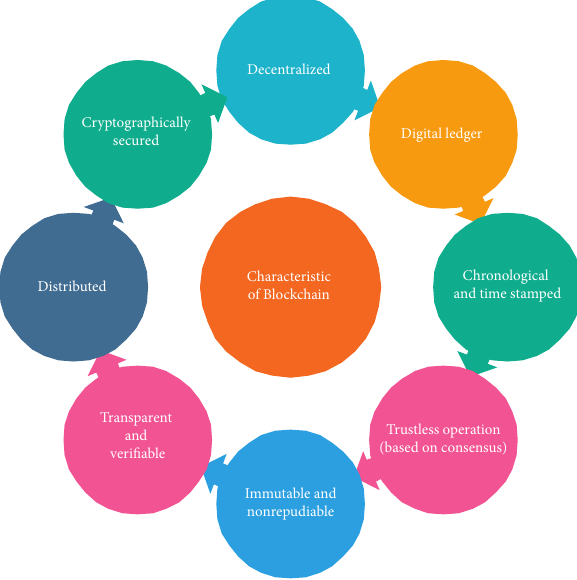
Figure 3: Characteristics of